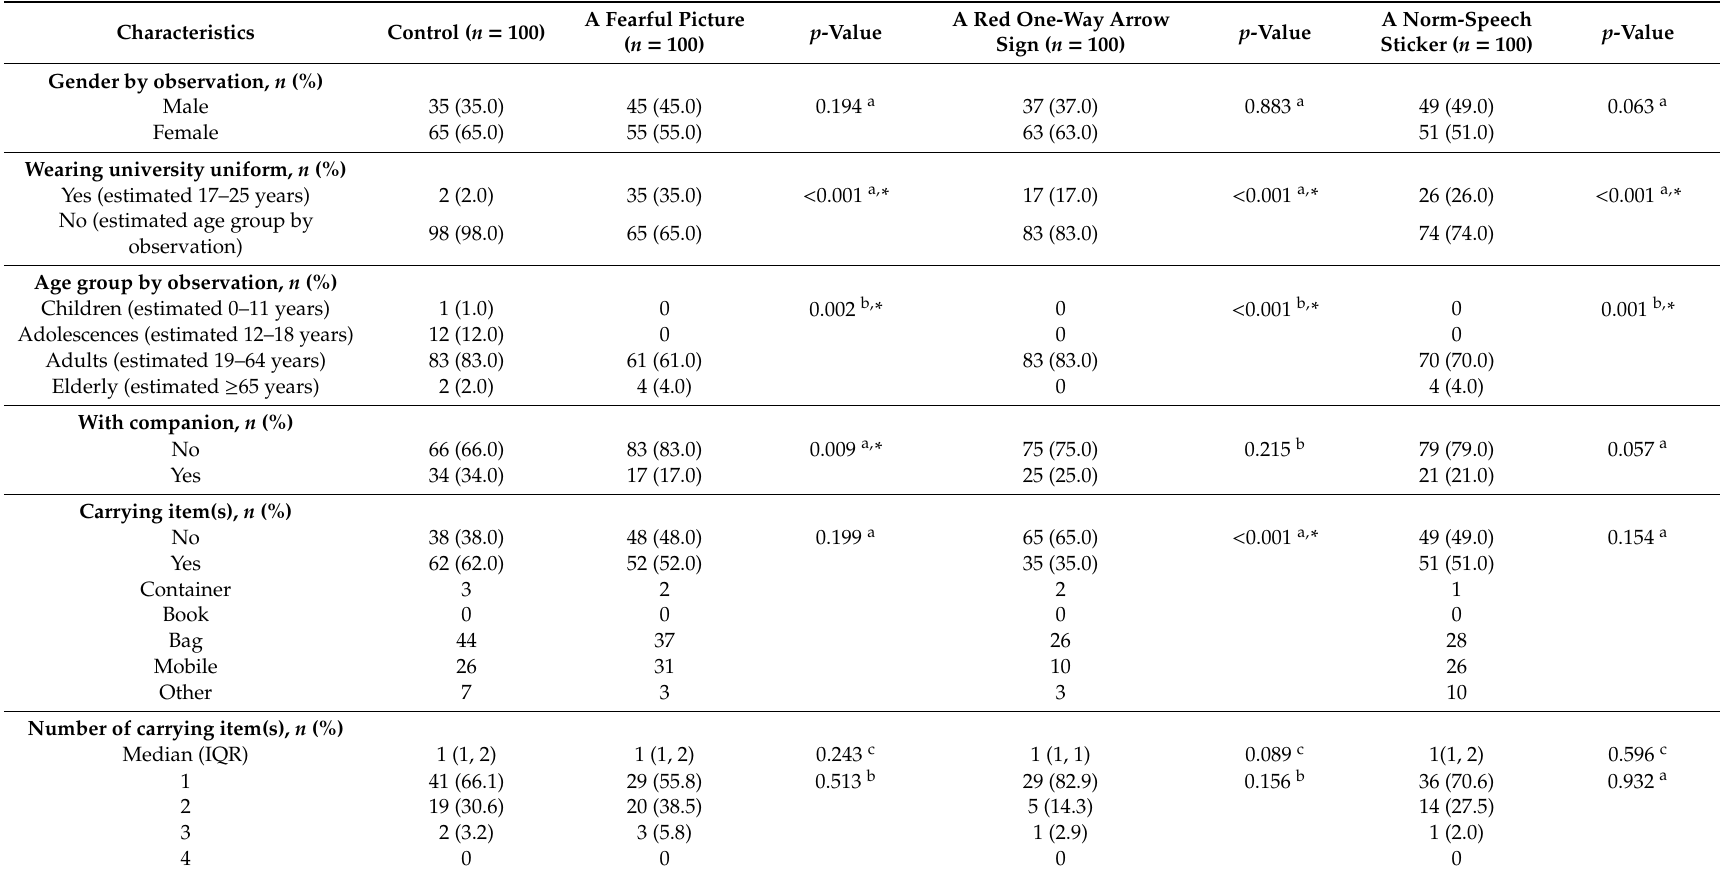
Table 1. Demographic data of the participants ( n =